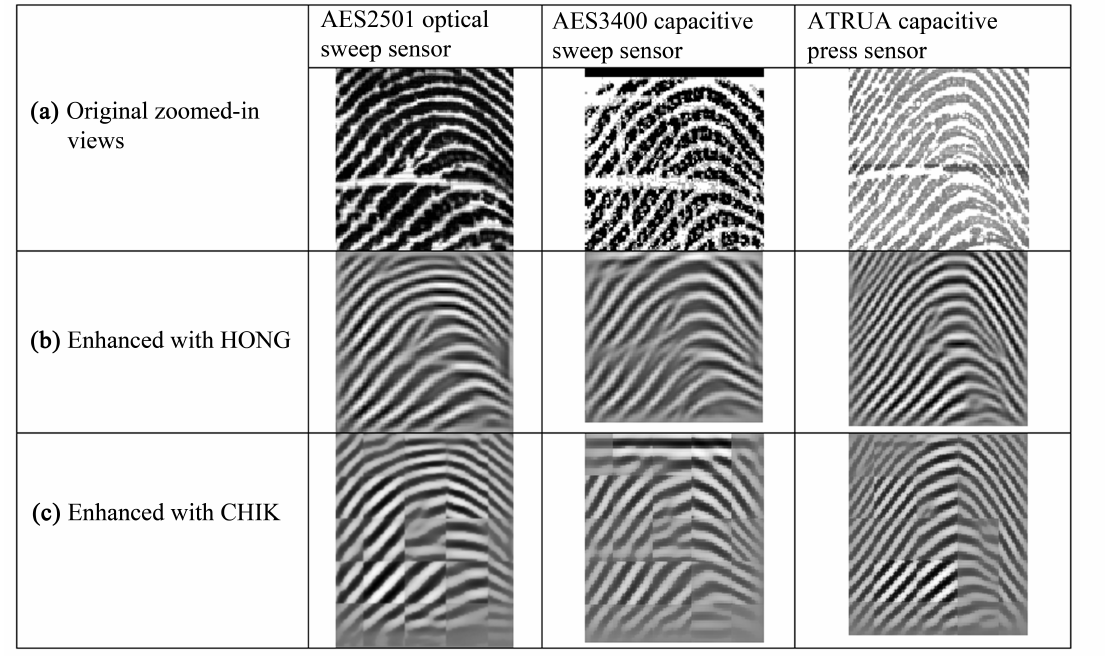
Figure 4. ( a ) Fingerprints from the same finger captured with three different sensors, ( b ) the corresponding fingerprints enhanced using the Hong et al. method, and ( c ) the corresponding fingerprints enhanced using the Chikkerur et al. method.